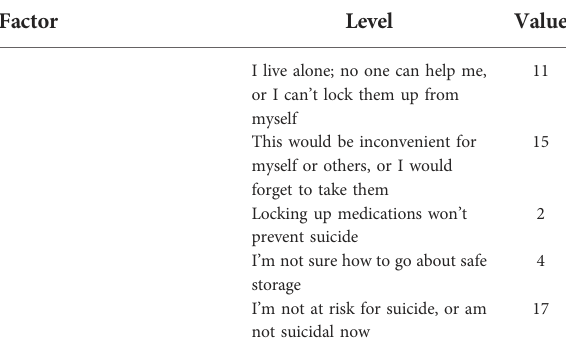
TABLE 4 Patient reported fi rearm and medication storage beliefs and